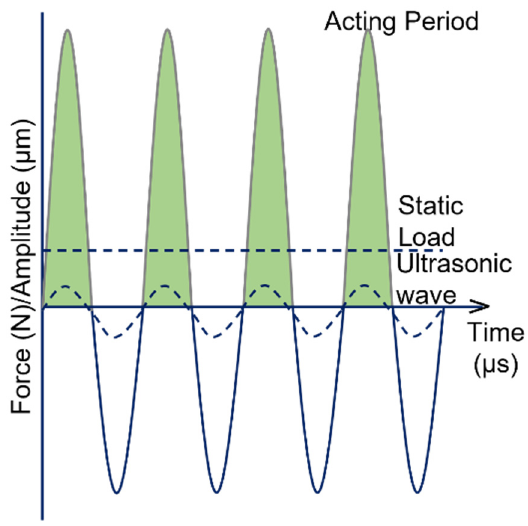
Figure 2. Load cycles in